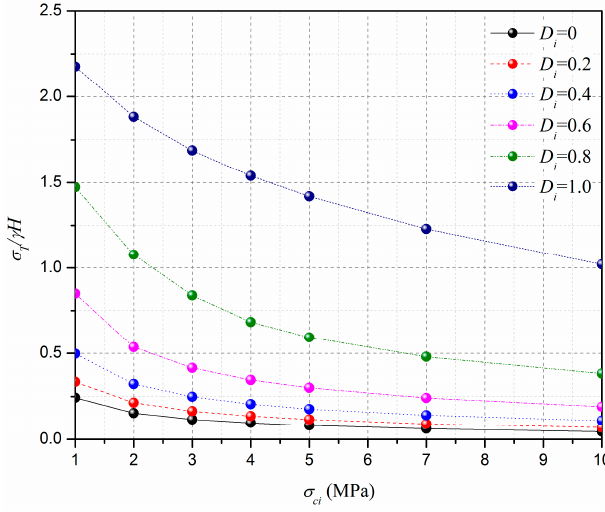
Figure 11. Effect of